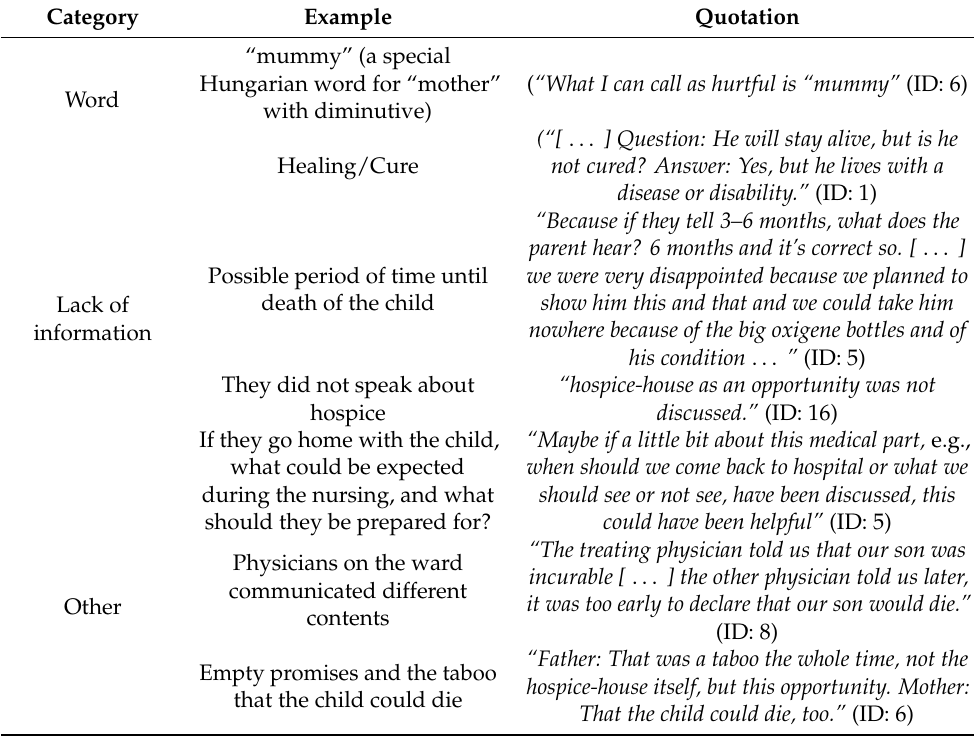
Table 4. Categories, examples, and quotations of Code 2.1.2 (negative verbal